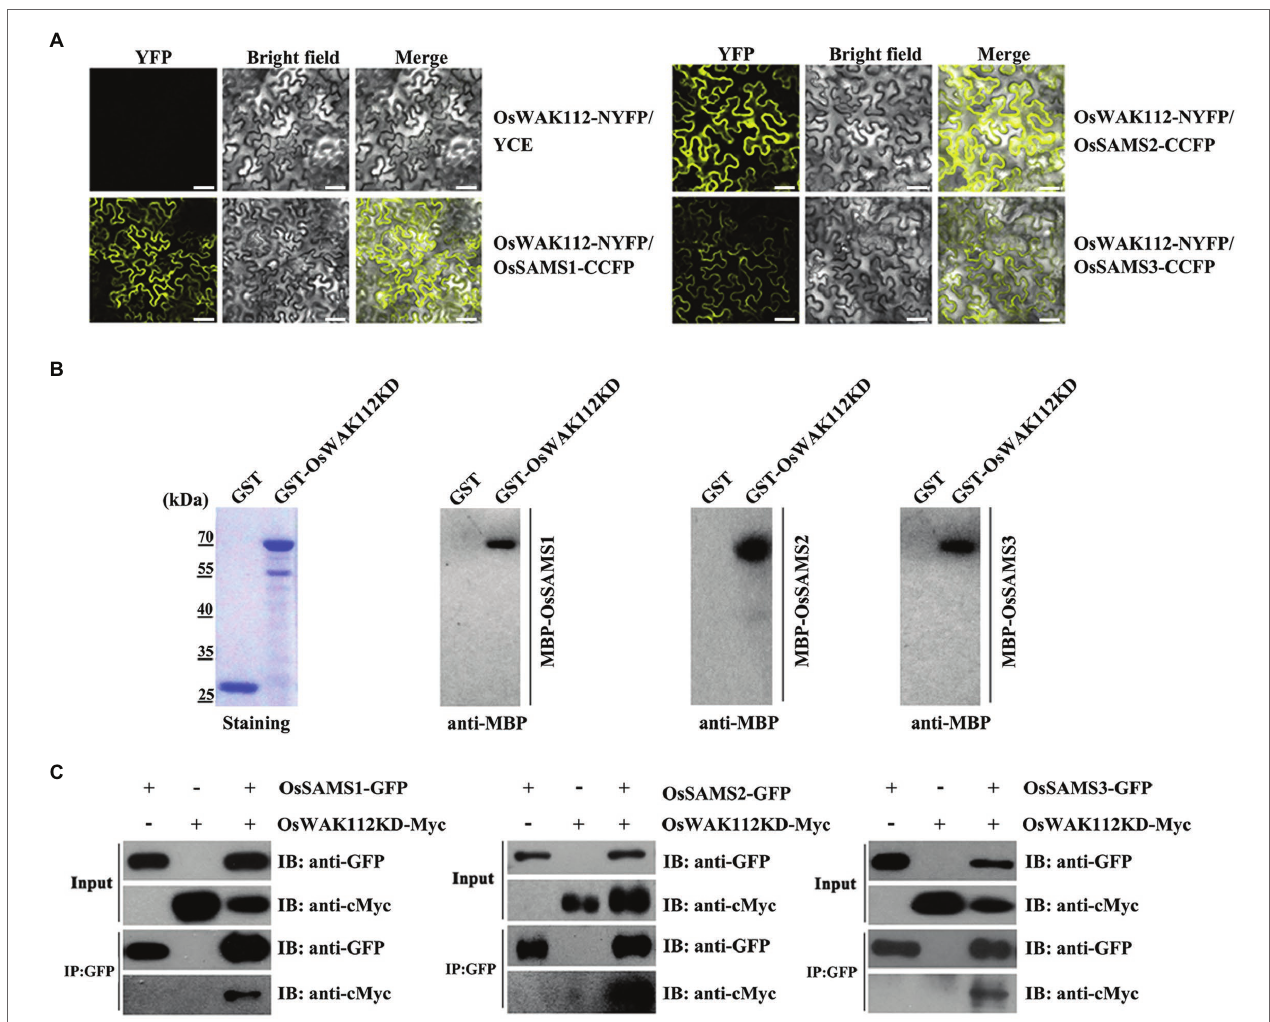
FIGURE 6 | OsWAK112 interacts with OsSAMS1, OsSAMS2, and OsSAMS3 in vitro and in vivo . (A) MBP-OsSAMSs bound to the GST-WAK112KD fusion but not to GST in a gel blot overlay assay. Coomassie blue staining in the left panel indicates the loading of GST-WAK112KD and GST. Bound proteins were probed with anti-MBP-HRP antibodies. OsWAK112 interacted with OsSAMSs in BiFC assays (B) and Co-IP assays (C) in transiently transformed N. benthamiana leaves. Scale bar = 50 μ m in (B)